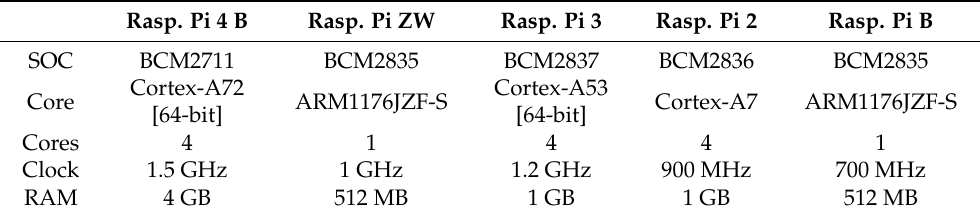
Table 2. Computational architectures of the swarm-based algorithms’